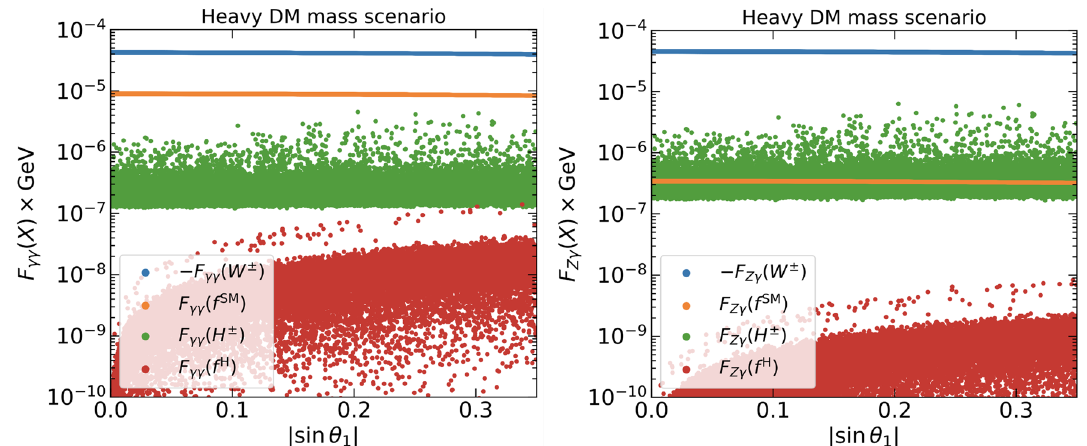
Fig. 14 The one-loop form factors for the individual particle run- ning inside the loop of h → γγ (left panel) and h → Z γ (right panel) processes as a function of | sin θ 1 | . The data points are taken in (cid:5)χ 2 < 5 . 99 region from CDF-2022+DM for the heavy DM mass scenario. The orange, green and red points represent the form factors